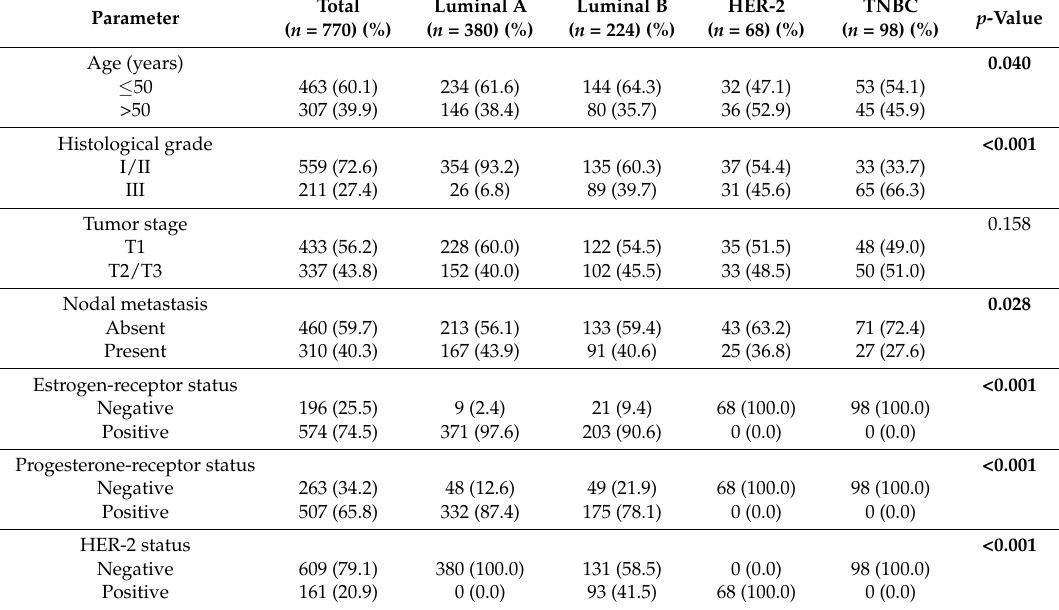
Table 1. Clinicopathological characteristics of patients by breast cancer molecular